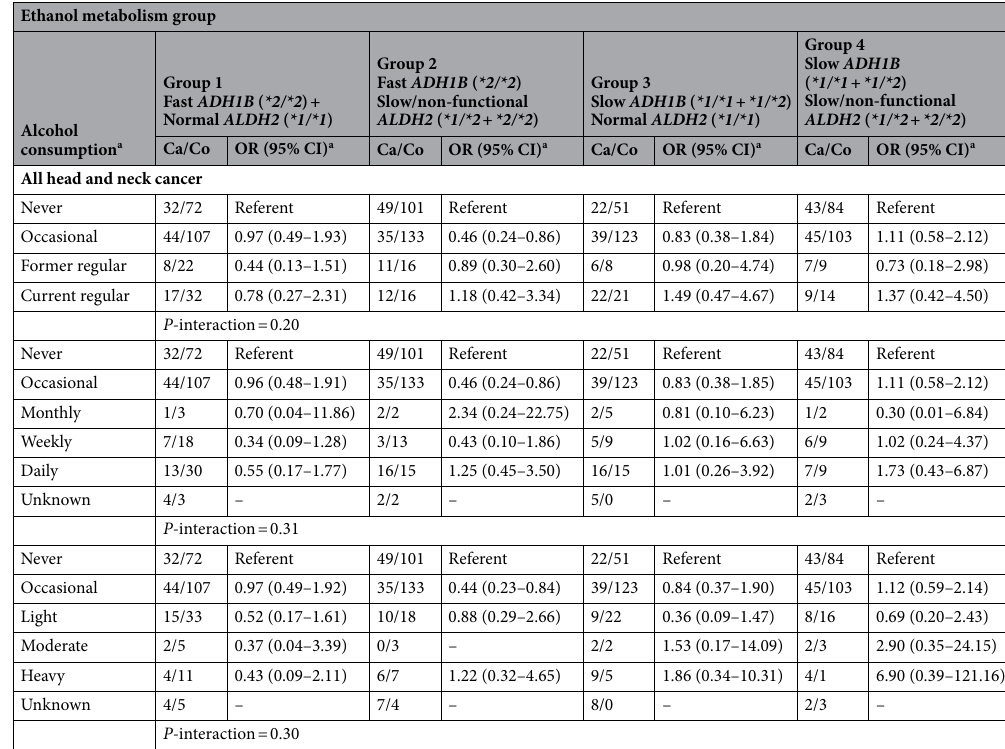
Table 6. The association between alcohol drinking and pancreatic cancer risk by the combination of ALDH2 rs671 and ADH1B rs1229984. CA case, CI confidence interval, CO control, OR odds ratio. a OR and 95% CI were calculated using unconditional logistic regression, adjusted for sex, age, education, cigarette smoking (pack-years), oral hygiene score, vegetable consumption, allergy, diabetes/glucose intolerance and BMI at two years before the pancreatic cancer diagnosis for the cases or before the interview date for the